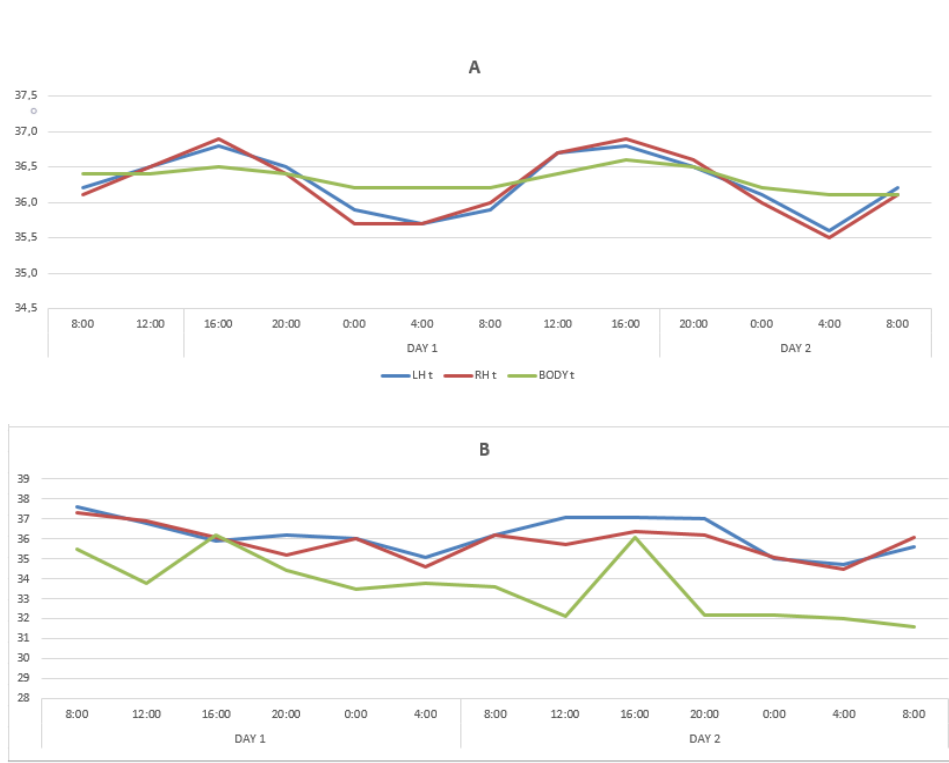
Figure 1. Changes in temperature of the LBT, RBT and BT in the cohorts of healthy subjects ( A ) and patients with DOC ( B ).